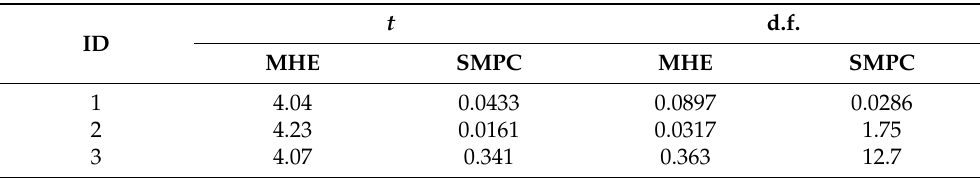
Table 6. Relative error (%) of calculating t statistic and degree of freedom (d.f.) in the secure federated t -test on each pair of classes as indicated by the ID.